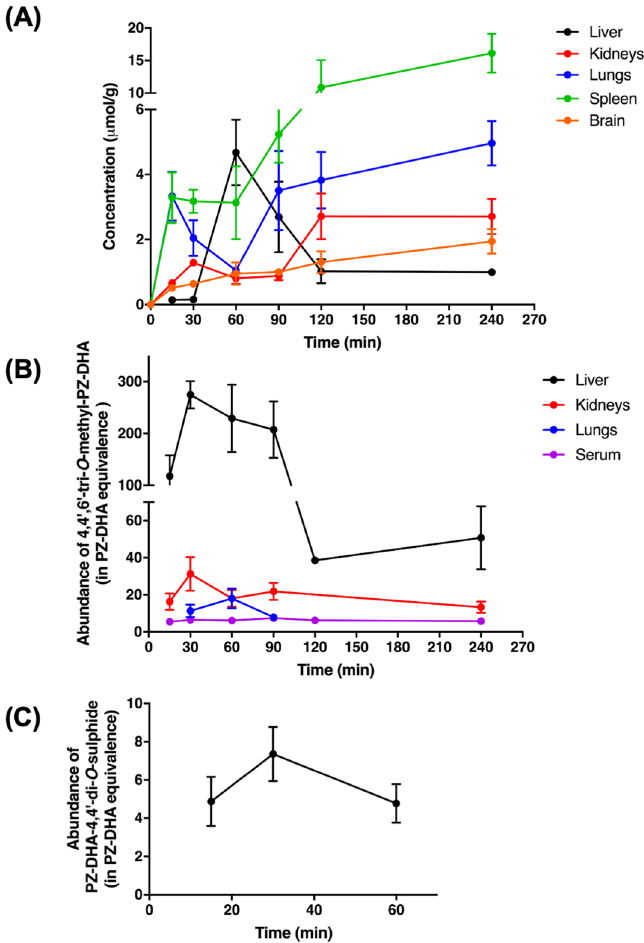
Figure 5. PZ-DHA and metabolites were detected in various organs of PZ-DHA-treated Balb/c female mice. PZ-DHA (100 mg/kg) was administered by intraperitoneal injection to Balb/c female mice and liver, lungs, kidneys, spleen and brain were harvested. Organs were homogenized and PZ-DHA in (A) liver, kidneys, lungs, spleen, and brain was identified and quantified using a calibration curve. The abundance of (B) 4,4 ′ ,6 ′ -tri- O -